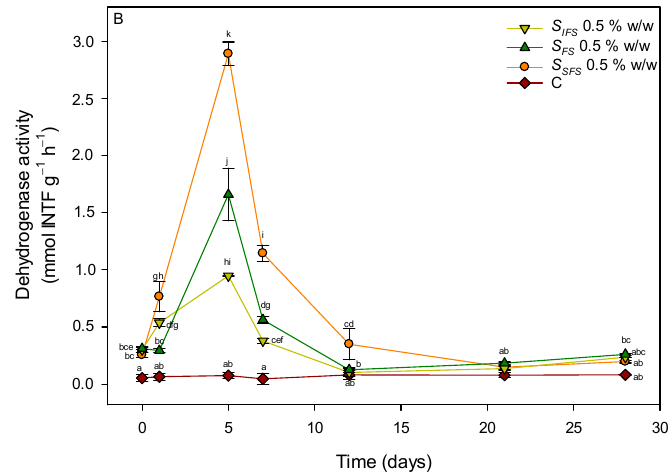
Figure 3. The dehydrogenase activity in the control soils and those treated with the different products at concentrations of 0.1% w / w ( A ) and 0.5% w / w ( B ). Points (mean ± SD) with the same letter(s) were not significantly different from each other ( p > 0.05). INTF: 2-p-iodo-3-nitrophenyl formazan.